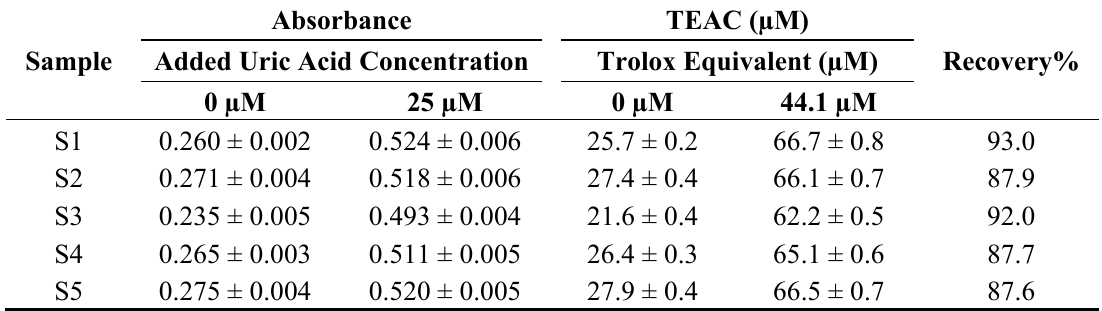
Table 5. Recovery assay results for two level addition of uric acid in five serum samples.